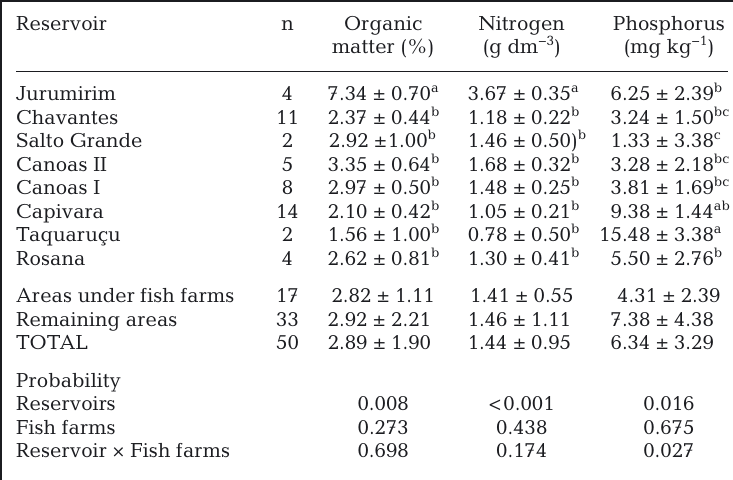
Table 7. Mean ± SE nutrient concentrations in the bottom sediment of the Paranapanema River artificial reservoirs (n = 50).Values followed by different letters in the same column are significantly different (p < 0.05, Kruskal-Wallis